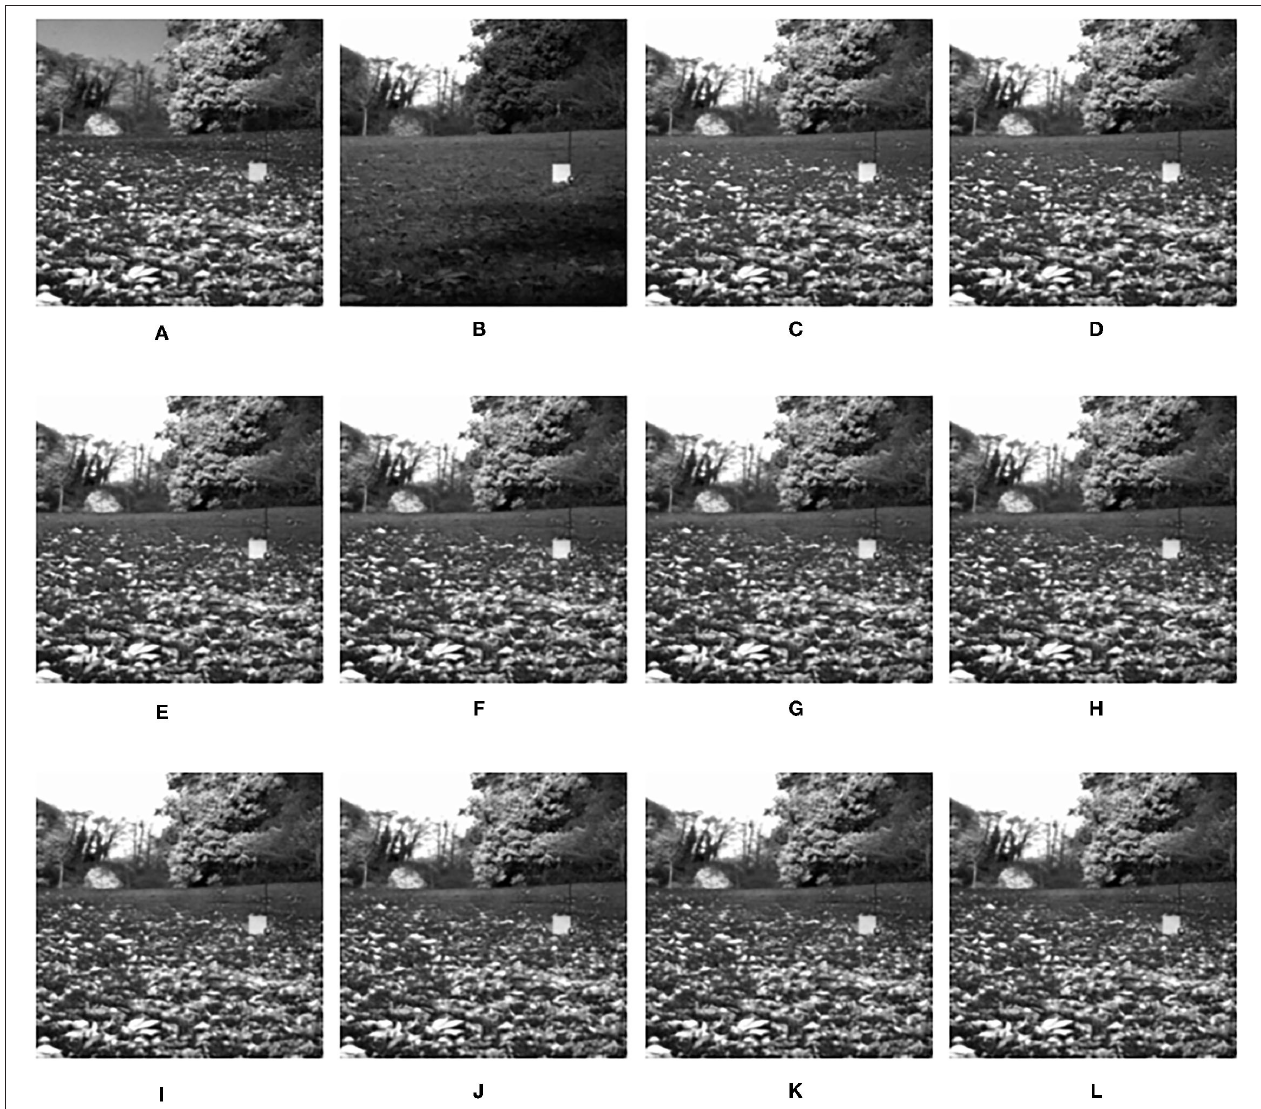
FIGURE 5 | The output fused images in patch size experiment. (A) original image (infrared image); (B) original image (visible image); (C) patch of size 2 × 2; (D) patch of size 4 × 4; (E) patch of size 6 × 6; (F) patch of size 8 × 8; (G) patch of size 10 × 10; (H) patch of size 12 × 12; (I) patch of size 14 × 14; (J) patch of size 16 × 16; (K) patch of size 18 × 18; (L) patch of size 20 ×